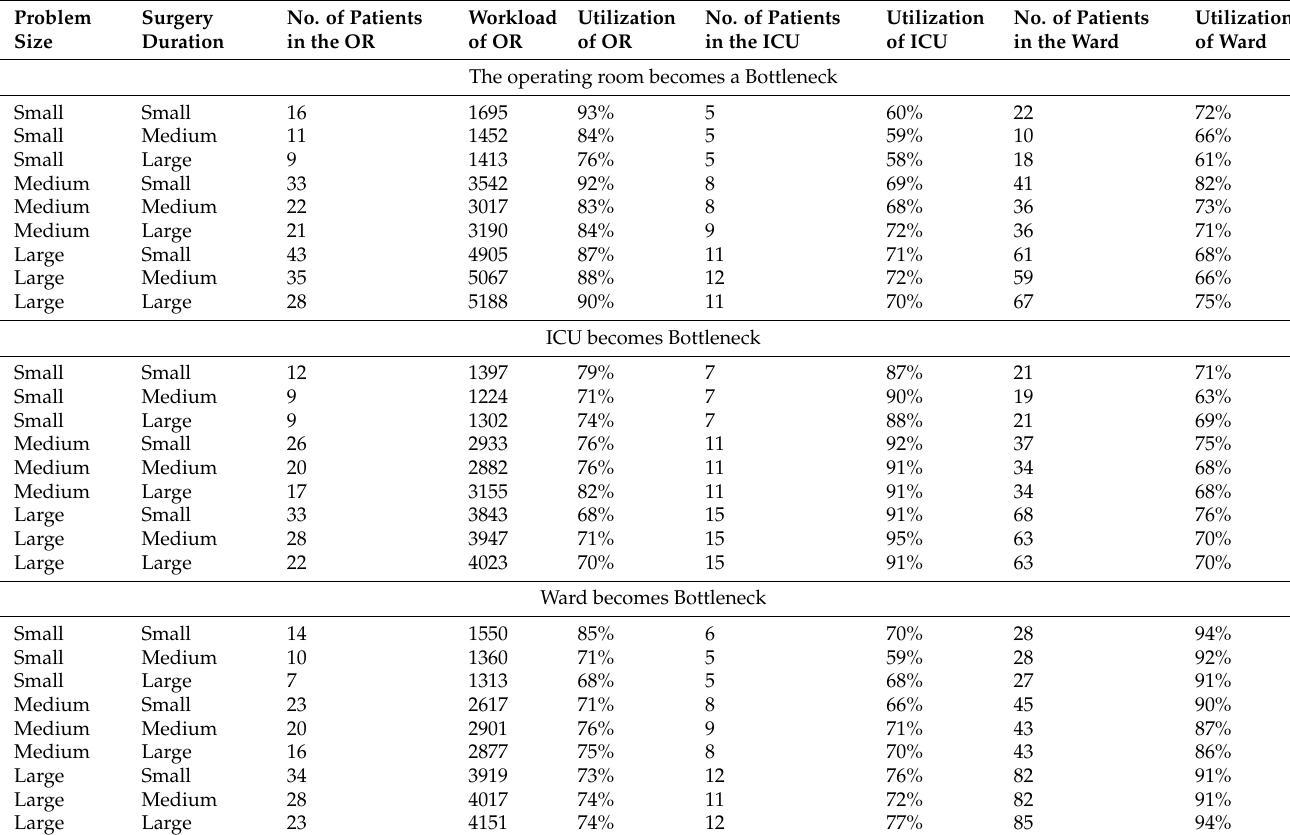
Table 4. Summary of results.